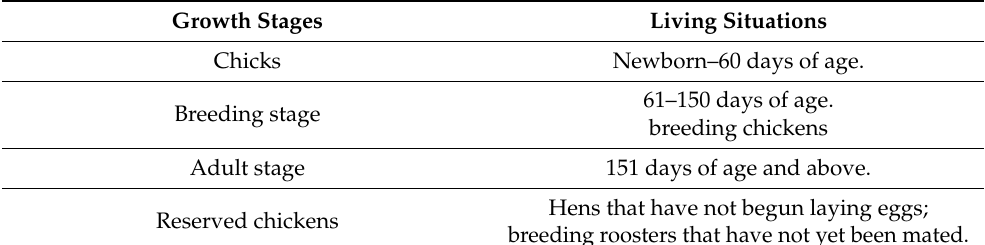
Table 1. Growth stages of chicken categorized by day-old ages.